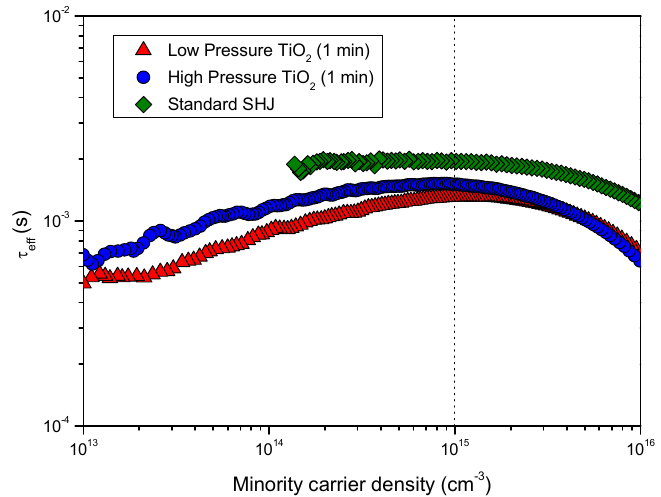
Figure 6. Injection-level-dependent effective lifetimes of the SHJ precursors with the electron selective contact consisting of a thin intrinsic a-Si:H layer capped with a TiO 2 film deposited in the low-pressure regime or high-pressure regime. For comparison, data for a standard SHJ cell precursor (with n-doped a-Si:H as the electron selective layer) are also included.